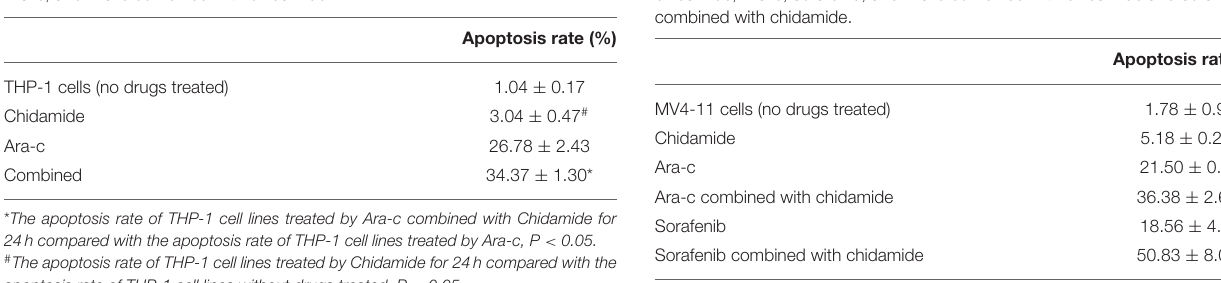
FIGURE 1 | performed to evaluate the apoptosis of MV4-11 cells treated with Ara-c or sorafenib alone or in combination with chidamide for 24h, and the apoptosis rate of MV4-11 cells in combination with chidamide team was higher than MV4-11 cells treated with Ara-c or sorafenib alone. (E) Western blot analyses were performed on THP-1 cells treated with Ara-c or in combination with chidamide for 24h, and the relative expression level of cleaved poly (adenosine diphosphate ribose) polymerase for THP-1 cells in combination with chidamide team was higher than THP-1 treated with Ara-c alone. (F) Western blot analyses were performed on MV4-11 cells treated with Ara-c or sorafenib alone or in combination with chidamide for 24h, and the relative expression level of cleaved poly (adenosine diphosphate ribose) polymerase for MV4-11 cells in combination with chidamide team was higher than MV4-11 cells treated with Ara-c or sorafenib alone. * p < 0.05, # p > 0.05.